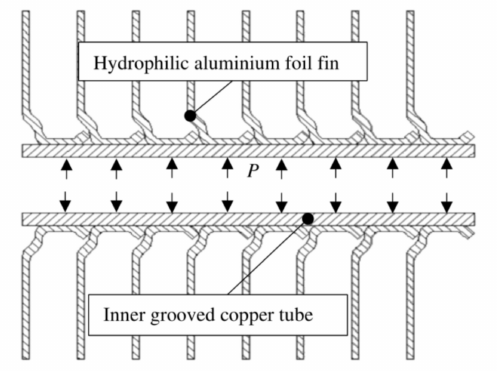
Figure 2. Diagram of the hydraulic expansion process in the air heat